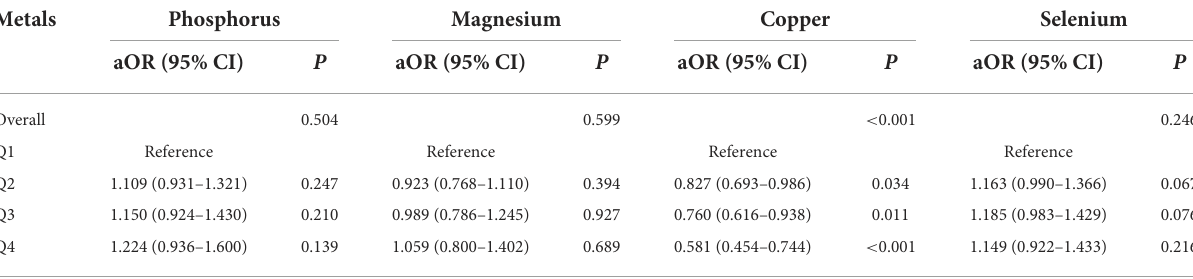
TABLE 5 Multivariate multi-metal model logistic regression of the relationship between heavy metals and kidney stone after PSM.